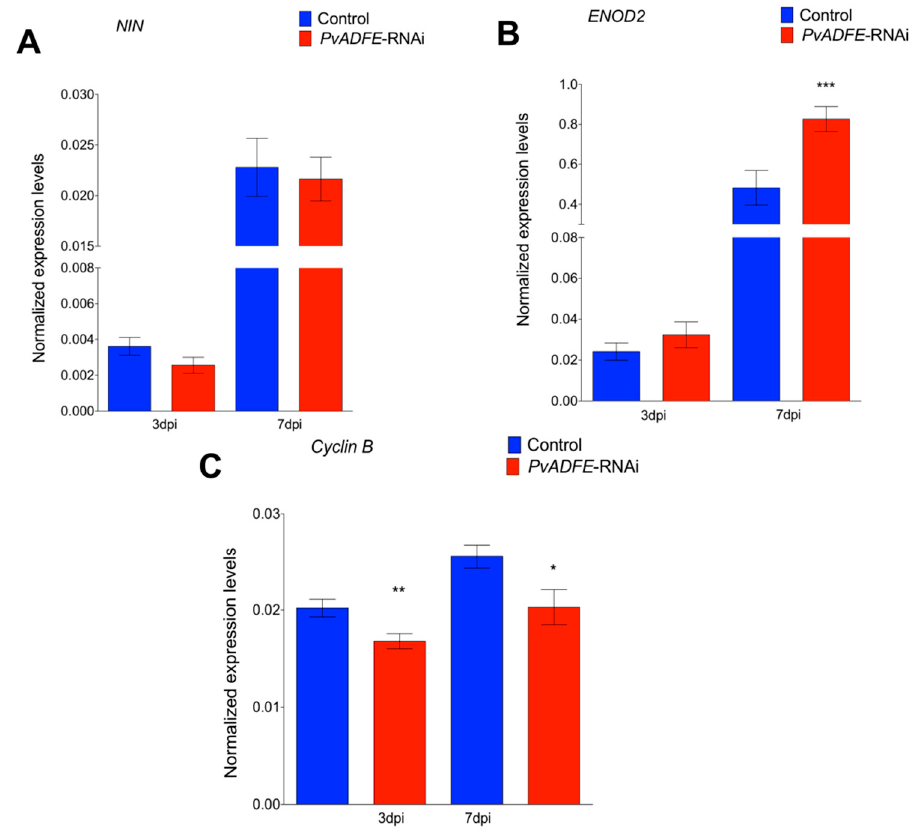
Figure 3. Reverse-transcription quantitative PCR analysis of early nodulins in PvADFE -RNAi and control transgenic roots after inoculation with R. tropici CIAT-899. ( A ) NIN , ( B ) ENOD2 , and ( C ) Cyclin B transcript accumulation profiles determined by RT-qPCR of total RNA isolated from PvADFE -RNAi and control transgenic roots at 3 and 7 days after inoculation with rhizobia. Elongation factor EF1 α was used as an endogenous reference gene for normalizing expression levels. Each bar represents mean ± SEM of two independent biological replicates with three technical repeats. * p < 0.05, ** p < 0.005, and *** p < 0.0001 based on Student’s t -test.